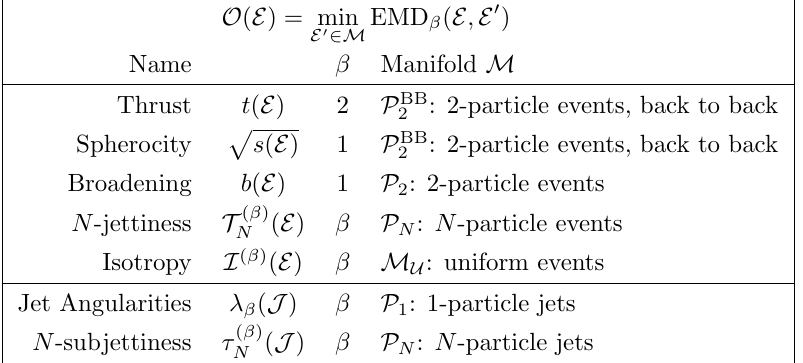
and a manifold , using the EMD E M